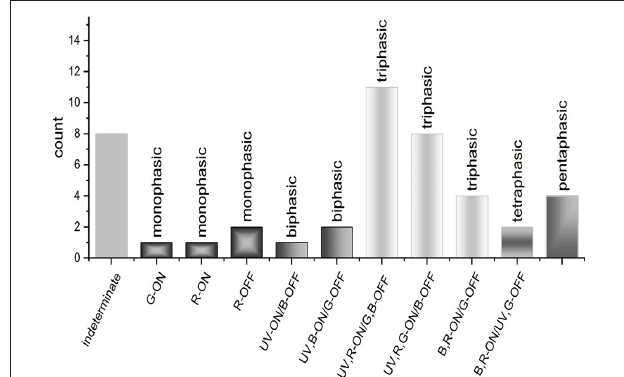
FIGURE 8 | GC spectral responses. Loose patch recordings from larval zebrafish GCs revealed a diversity of response types, most of which are spectrally multiphasic. Triphasic responses were the most abundant type identified and could be subdivided into three distinct spectral patterns. Bi-, tetra-, and pentaphasic responses were also recorded (Connaughton and Nelson,